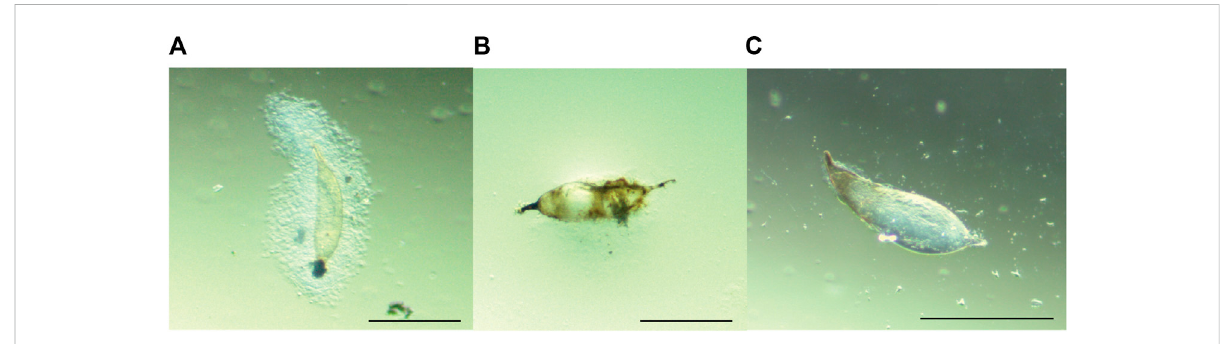
FIGURE 1 Melanotic encapsulation responses of (A,B) B. dorsalis and (C) C. cosyra . Figure 1A was taken at 24 hpp, Figures 1B,C were taken 36 hpp. Scale bars = 300 μ m.